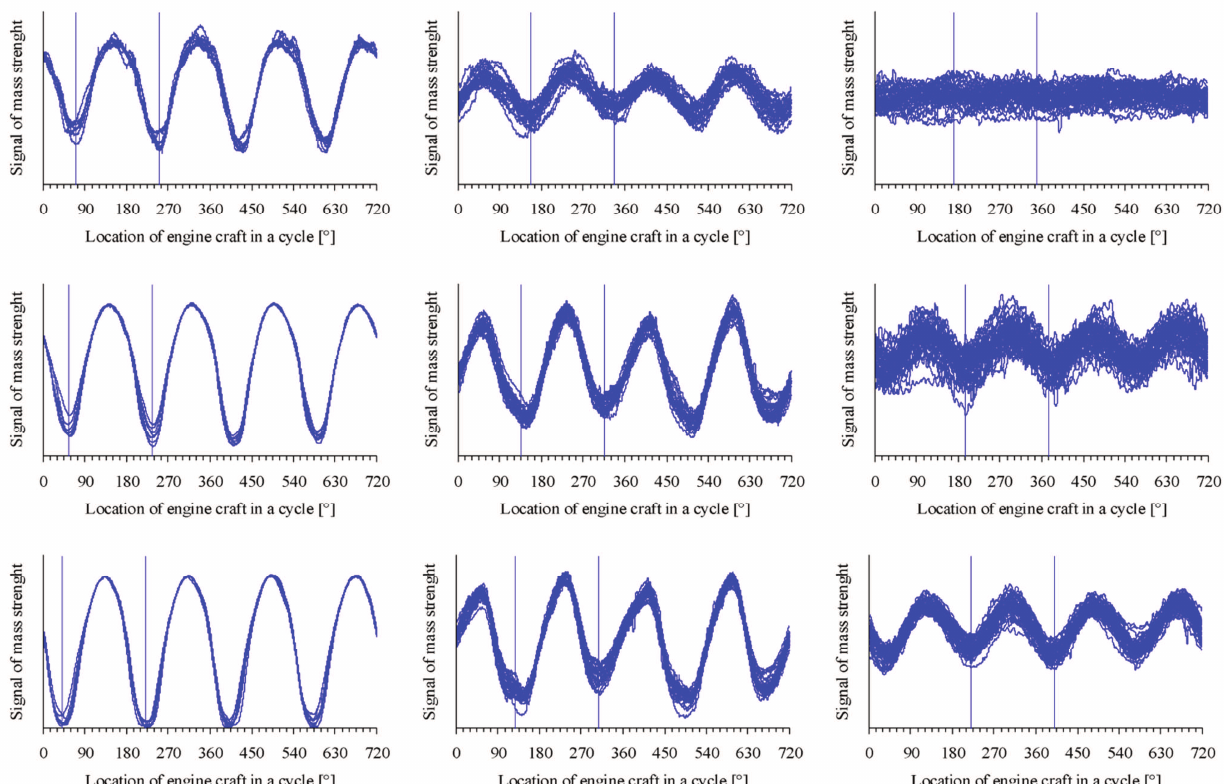
Fig. 2. Timing of m a signal of the function of crankshaft for different rotational speeds and openings angle of the throttle valve (in the columns: „small”, „medium”, „big” rotation speed; in the rows: „small”, „medium”, „big” opening angle of the throttle